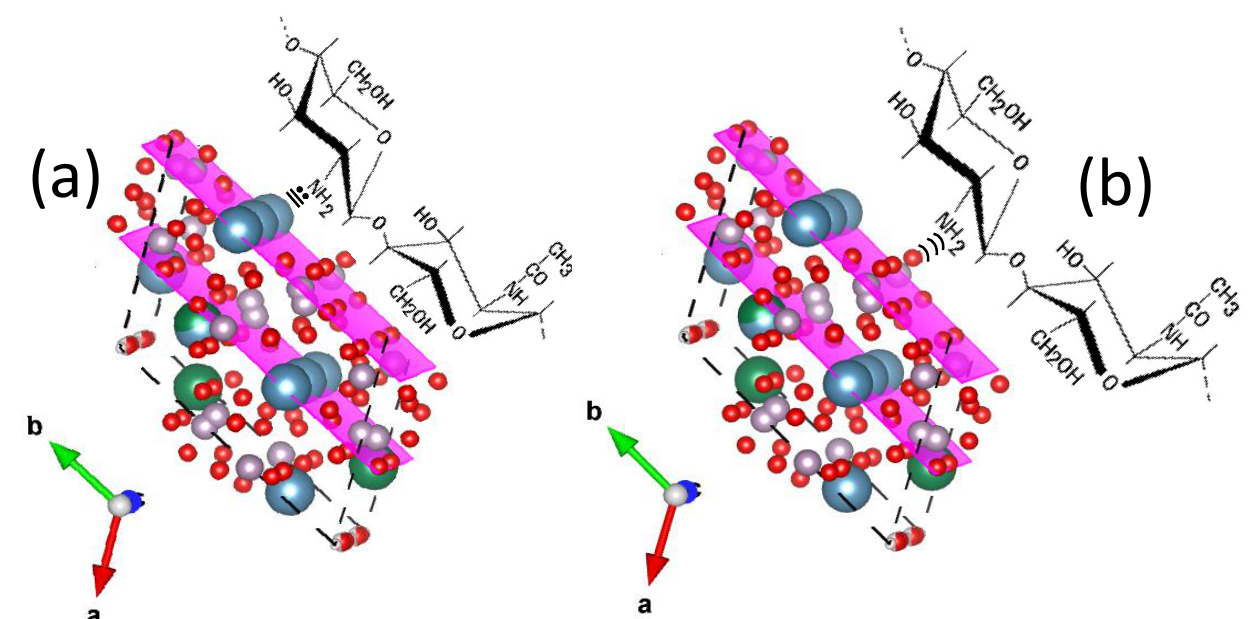
Figure 9. Schematic representations of possible chemical interactions between ( a ) calcium ion in HAp and amine groups in chitosan molecules, and ( b ) hydrogens in amine groups of chitosan and oxygen atoms in phosphate groups in HAp. The (300) planes were used for this representation.